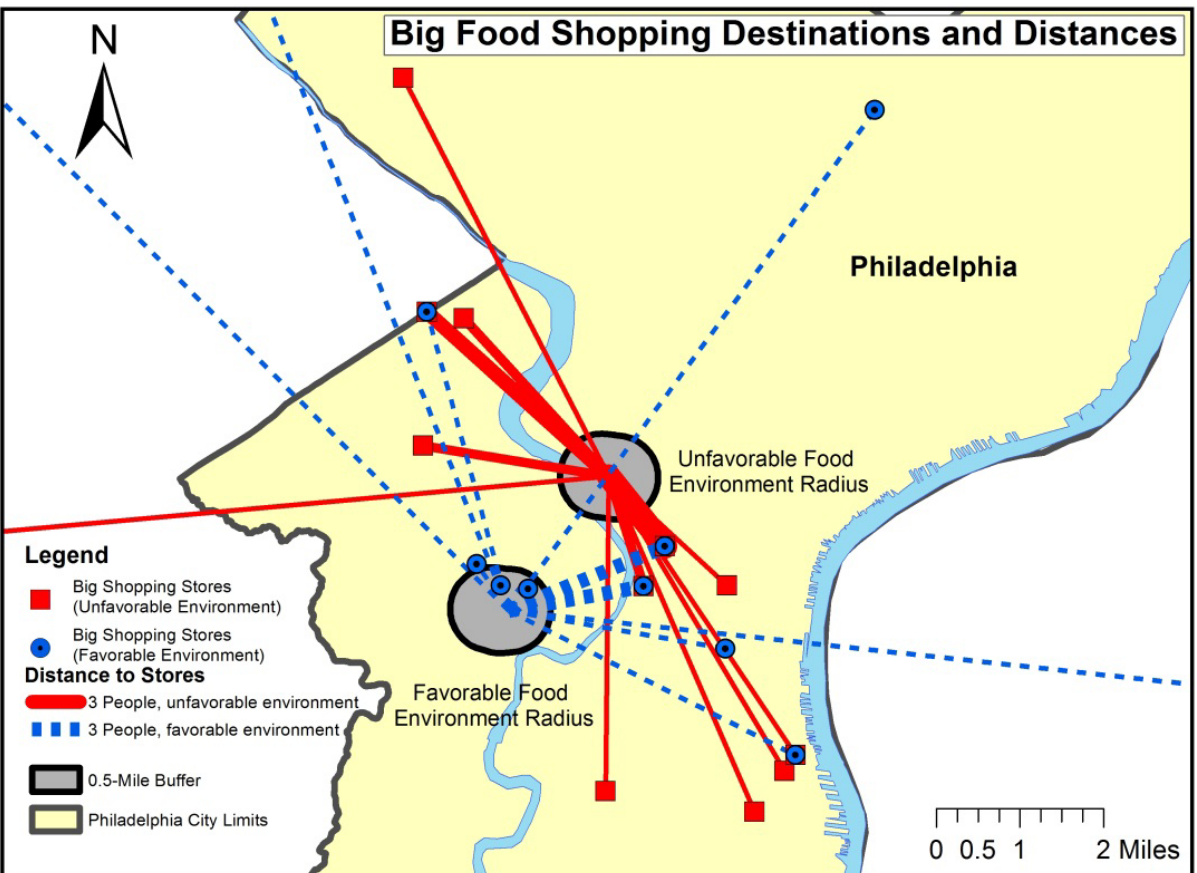
Figure 1. Euclidean distance between the favorable and unfavorable food environment street segments and food stores for big food shopping